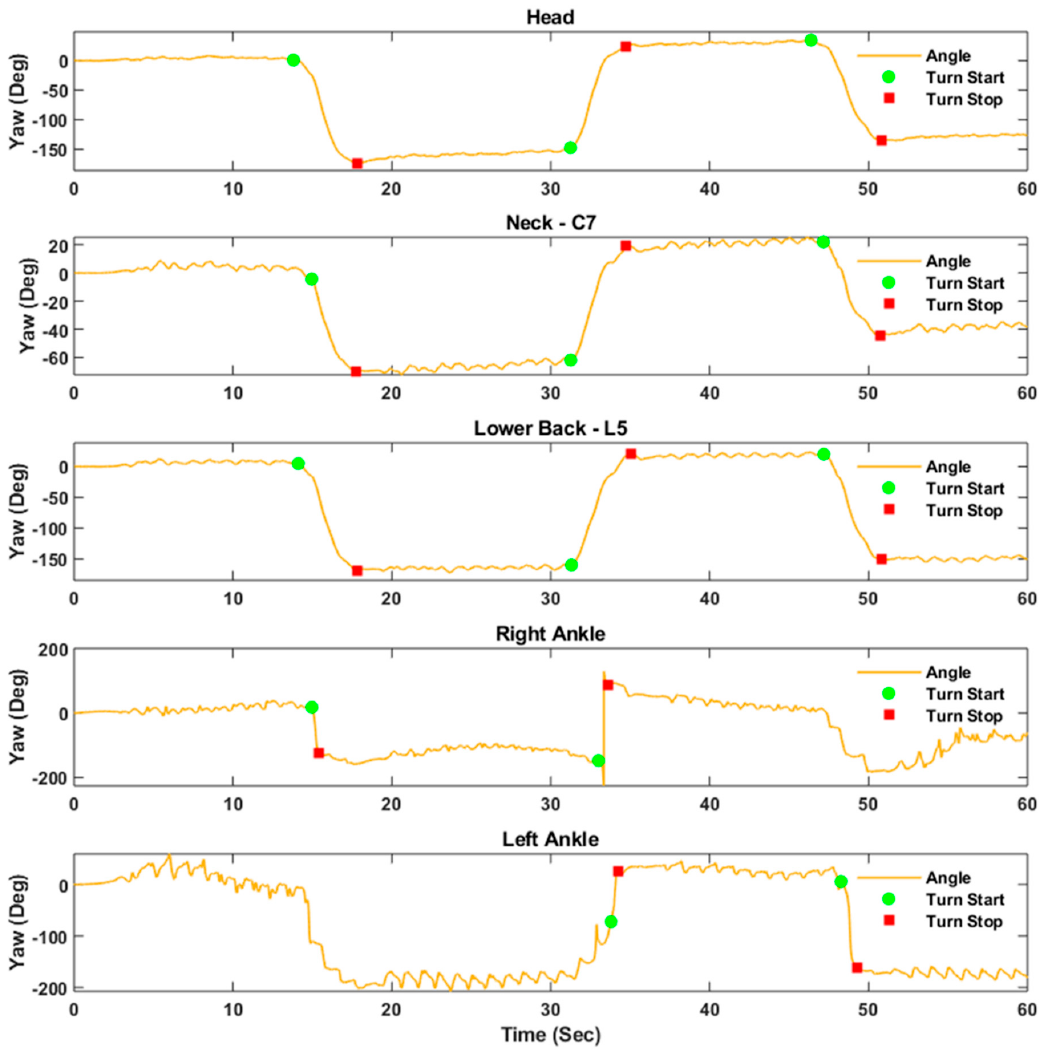
Figure 2. Turn start and turn end identification from each of the sensor attachments for one PD participant